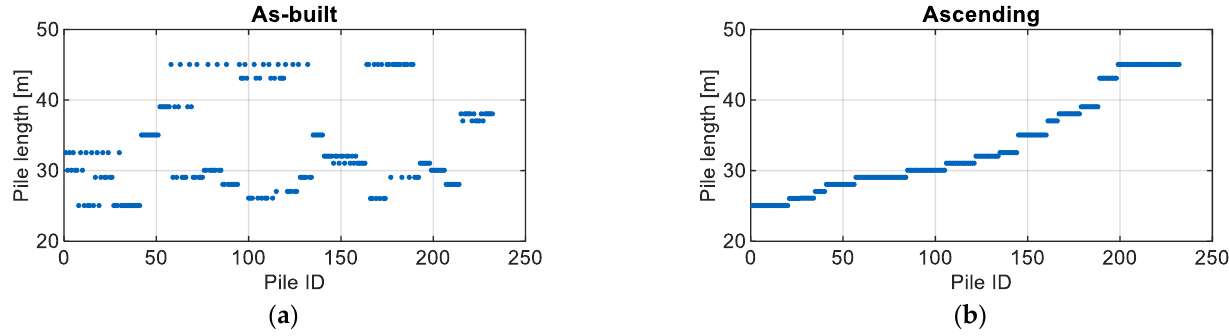
Figure 14. Construction sequence of piles with respect to their length: ( a ) as-built; ( b ) ascending.